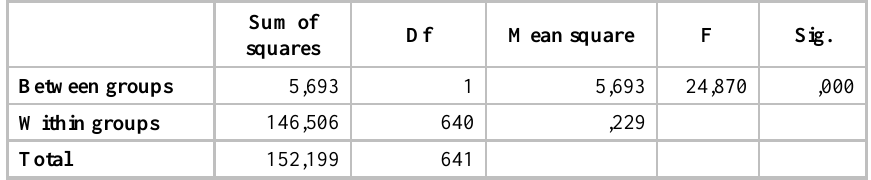
Table 6. Shopper approach behaviour Sum of Df Mean square F Sig. squares Between groups 5,693 1 5,693 24,870 ,000 Within groups 146,506 640 ,229